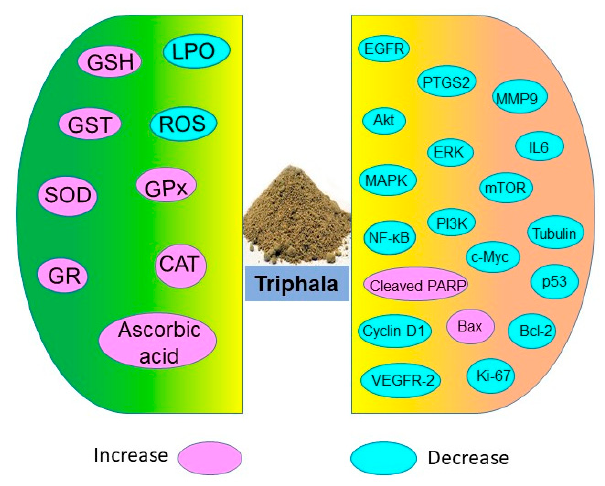
Figure 3. Antioxidative and chemoprotective molecules targeted by Triphala.